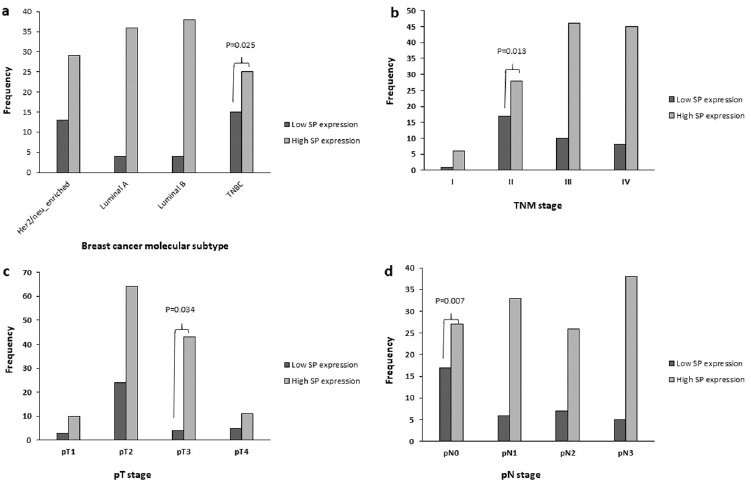
Fig 3. Distribution of substance P (SP) expression in breast cancer cases. (a) SP expression level in different breast cancer molecular subtypes. (b) SP expression level in breast cancer cases of different TNM stages. (c) SP expression level in breast cancer cases of different pT stages. (d) SP expression level in breast cancer cases of different pN stages. TNBC, triple negative breast cancer. Bonferroni Chi-Square residual analysis was performed to identify significant differences between breast cancer subgroups. Adjusted p-values were calculated as 0.05/n tests